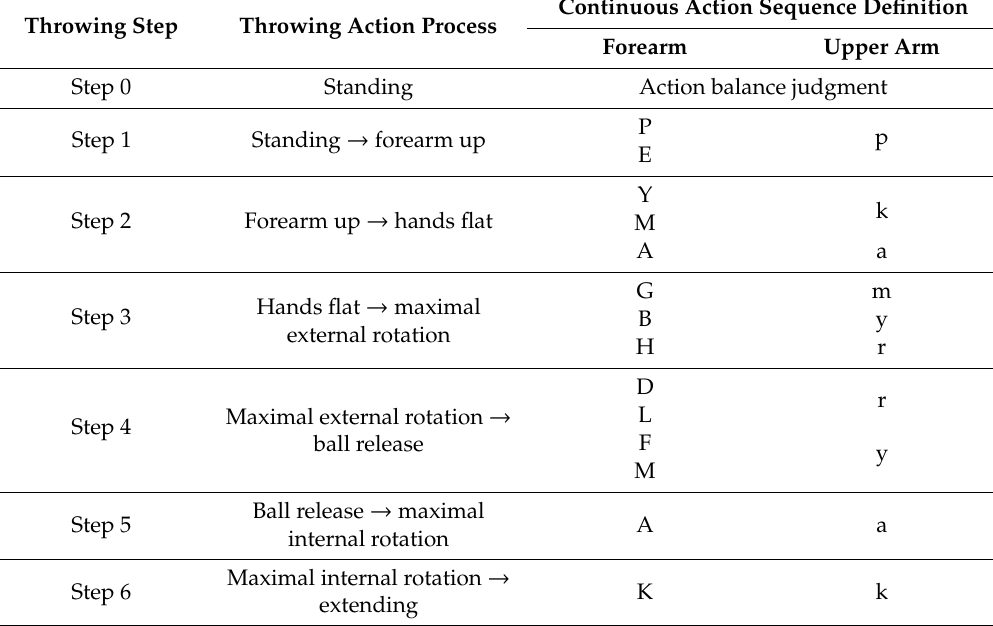
Table 2. Throwing action sequence